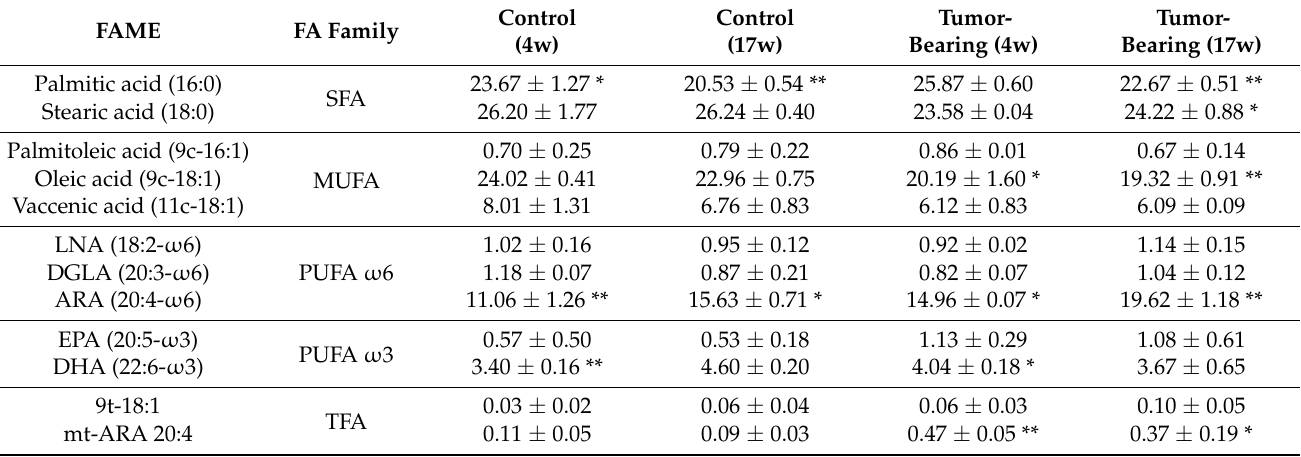
Table 2. Relative quantitative percentages (% rel. quant.) of fatty acid methyl esters (FAME) obtained from brain tissues of control SCID mice and tumor-bearing SCID mice at different ages 1